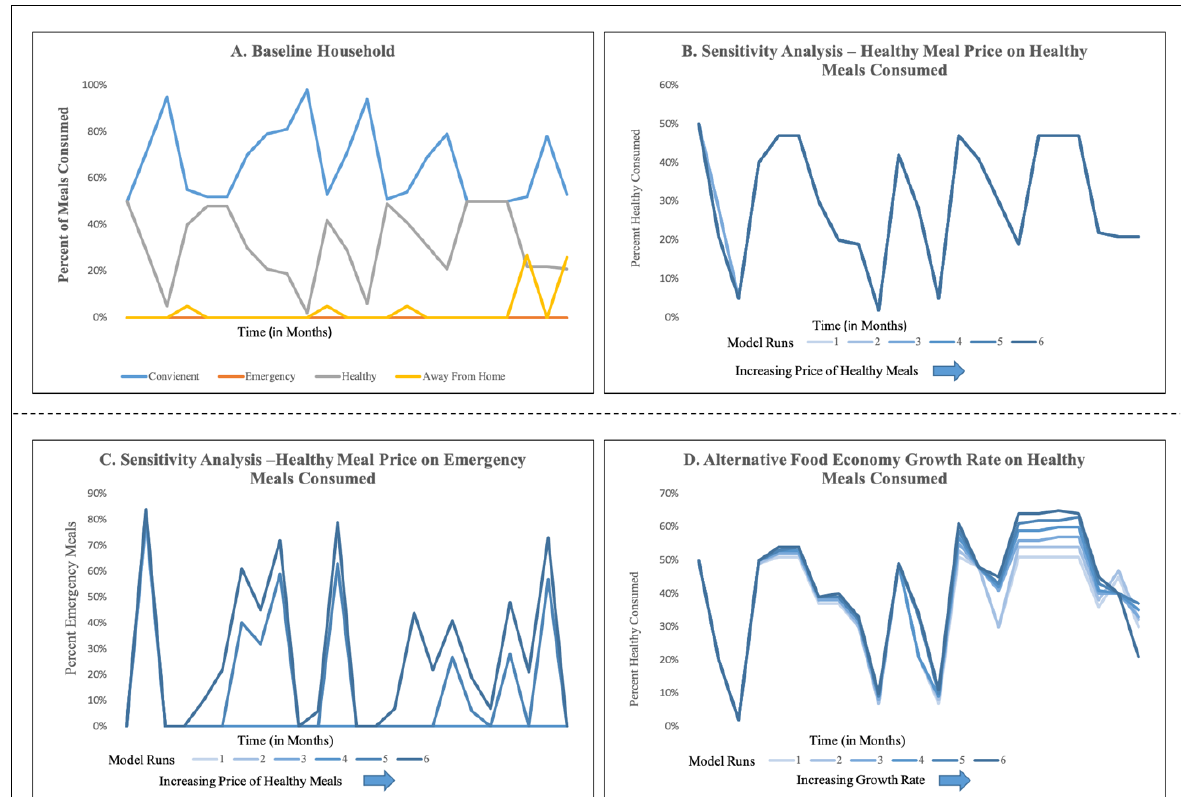
Figure 3. Reference Mode Model Output and Sensitivity